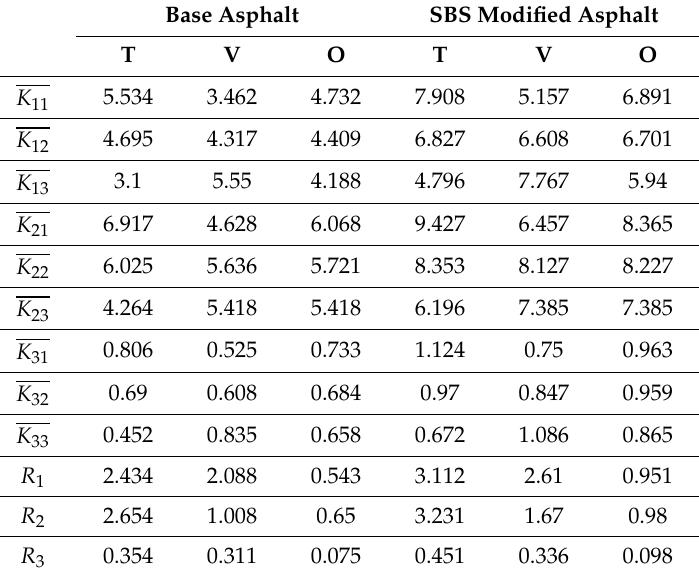
Table 13. The results of orthogonal